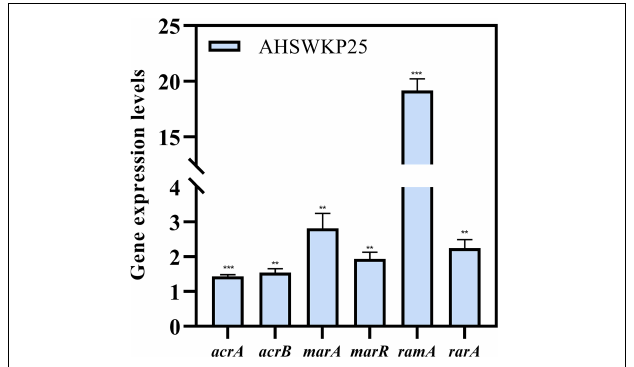
FIGURE 5 | Relative expression levels of acrA , acrB , marA , marR , ramA, and rarA genes in AHSWKP25. Gene expression levels were normalized using the rpoB (RNA polymerase) gene. The experiment was repeated in triplicate independently, and data are expressed as the mean ± SD (standard deviation). ** P < 0.01; *** P < 0.001 by Student’s t